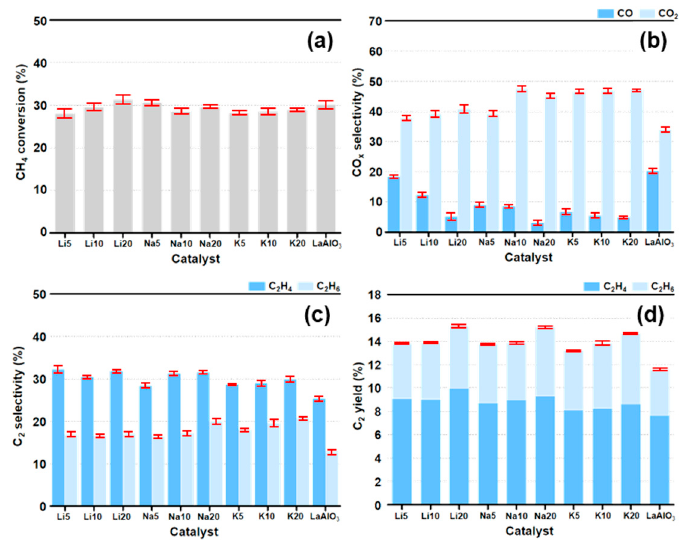
Figure 2. Catalytic activities in terms of the prepared catalyst in the oxidative coupling of methane (OCM): ( a ) CH 4 conversion (%), ( b ) CO x selectivity (%), ( c ) C 2 selectivity (%), and ( d ) C 2 yield (%).